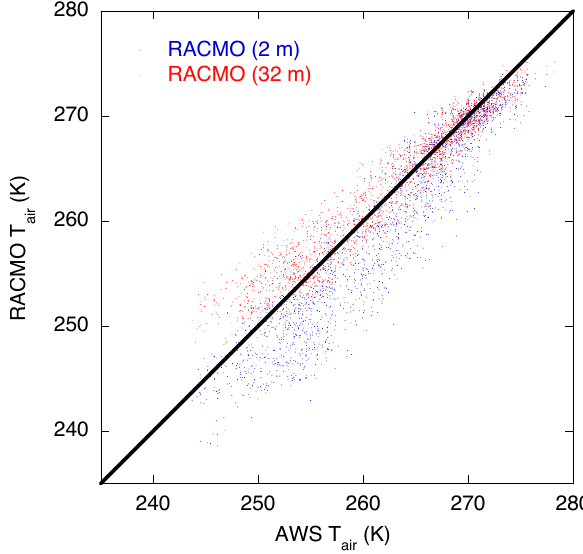
Fig. 2. Scatterplot of 3-hourly RACMO air temperatures at heights of 2 m (blue) and 32 m (red) versus observed air temperatures at ∼ 4 m above the surface at the AWS site for the period of March 2009 to November